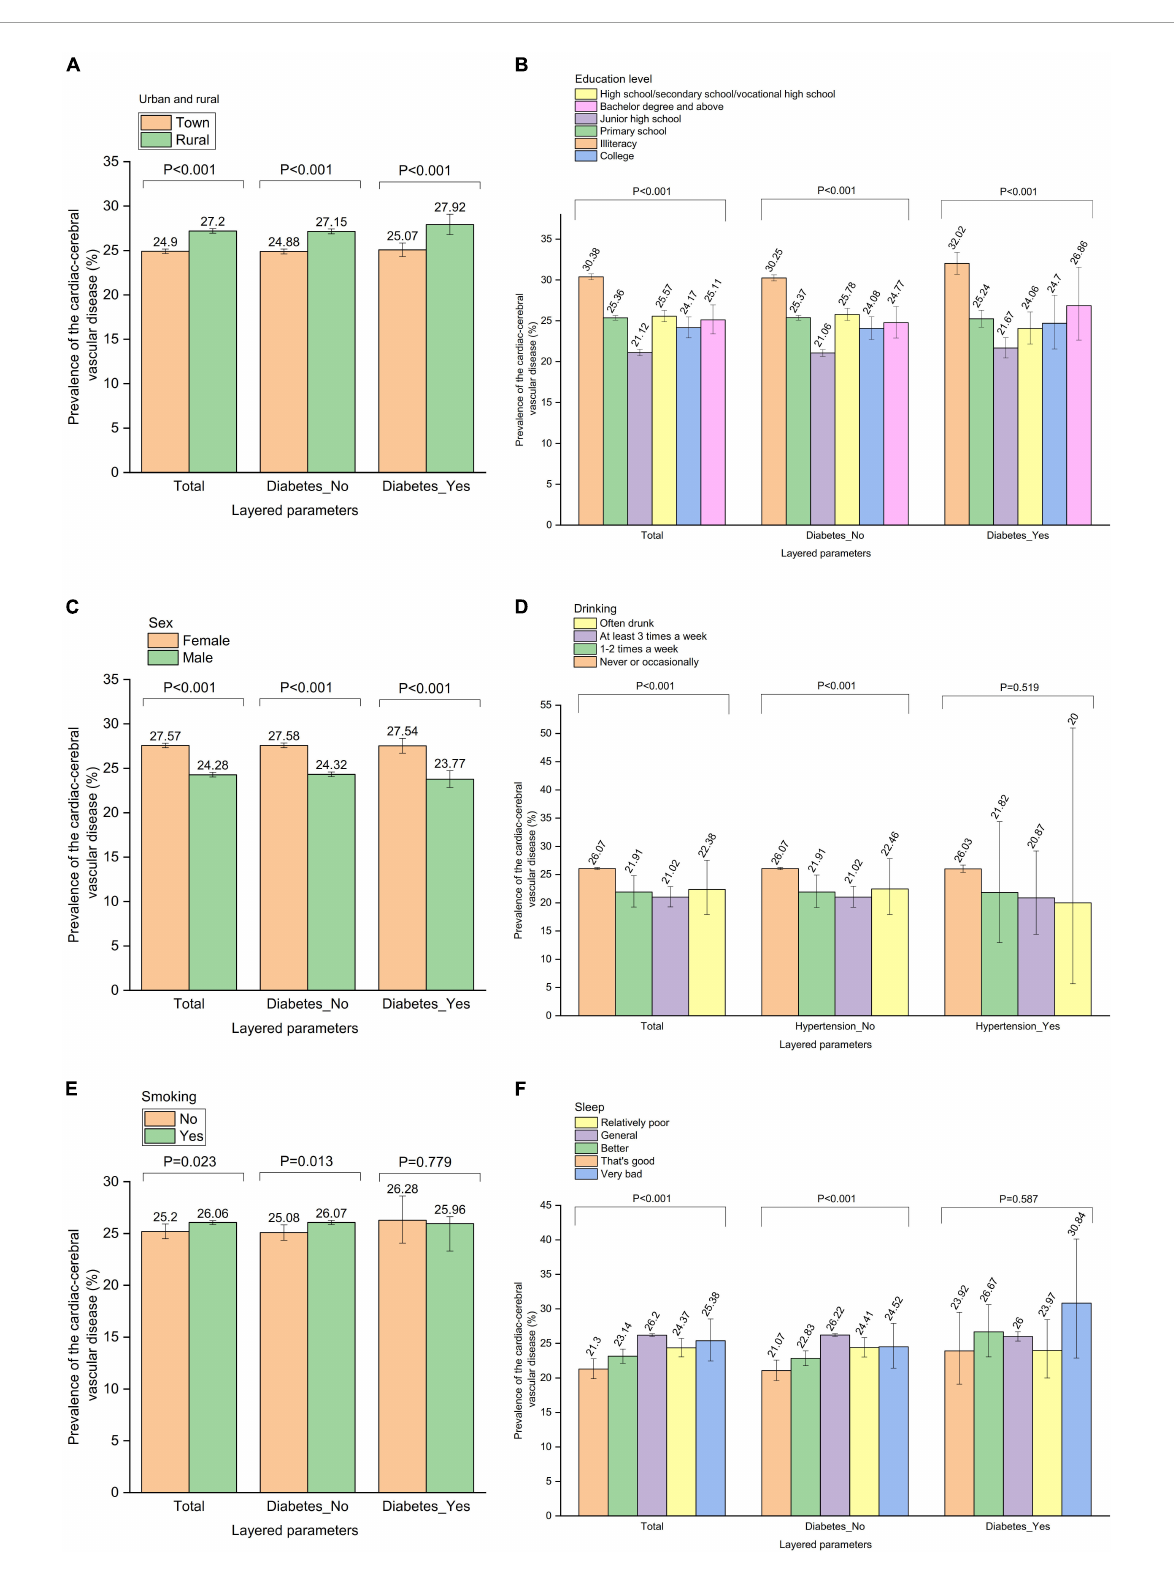
FIGURE6 The relationship between parameters and cardiac-cerebral vascular disease was further analyzed by “diabetes” stratification. Prevalence of the cardiac-cerebral vascular disease by (A) “Urban and rural” stratification, (B) “Education level” stratification, (C) “Sex” stratification, (D) “Drinking” stratification, (E) “Smoking” stratification, (F) “Sleep”